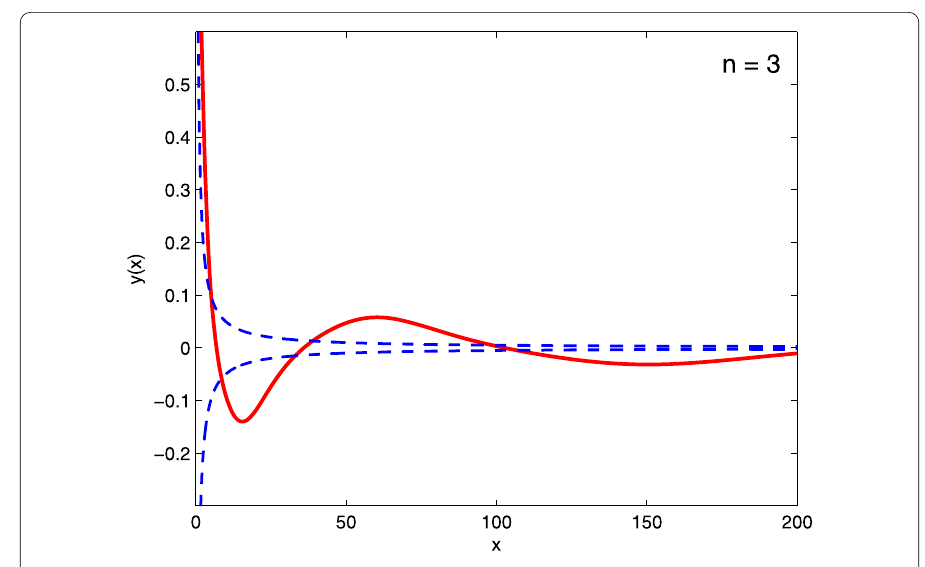
Figure 3 The numerical solution of the spherical equation (8) with D = 3, n = 3, and boundary conditions y (0) = 1 and y (cid:2) (0) = 0. The solution turns around every time it overshoots the region of no oscillations between the dashed curves y ± = ± 1/(2 x